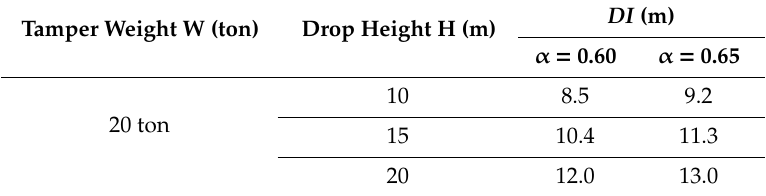
Table 4. Estimation of improvement depth using Equation (1) for various tamper drop heights.